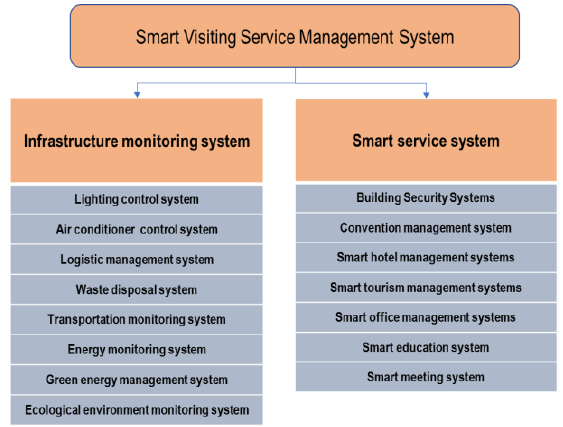
Figure 2. Smart visiting service management in Huangguan.